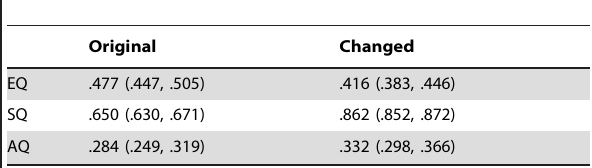
Table 1. The Pearson correlations, and their 95% confidence intervals in parentheses, between the scores on the critical items and the remaining items for the unchanged and changed versions, for EQ, SQ, and AQ.